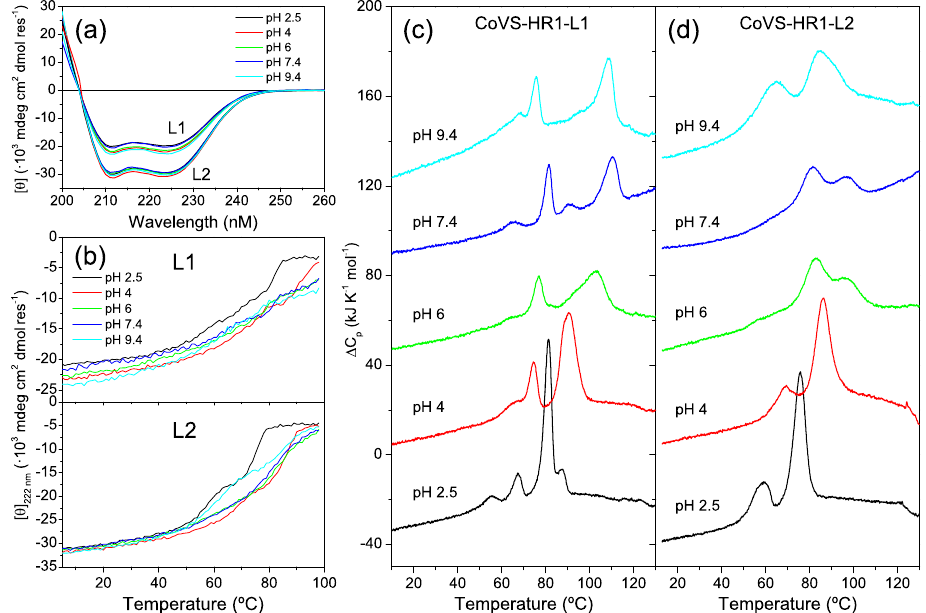
Figure 3. Structure and stability of the CoVS-HR1 L1 and L2 proteins. ( a ) Far-UV CD spectra of L1 and L2 measured with 15 μ M protein solutions at varied pH and 25 °C. The spectra were normalized as mean residue molar ellipticity. ( b ) Thermal scans monitoring the CD ellipticity at 222 nm under the same conditions as in panel ( a ). ( c , d ) DSC thermograms of L1 ( c ) and L2 ( d ) proteins measured at 30 μ M at varying pH values, as indicated near each curve. The thermograms are artificially displaced along the vertical axis for the sake of clarity.